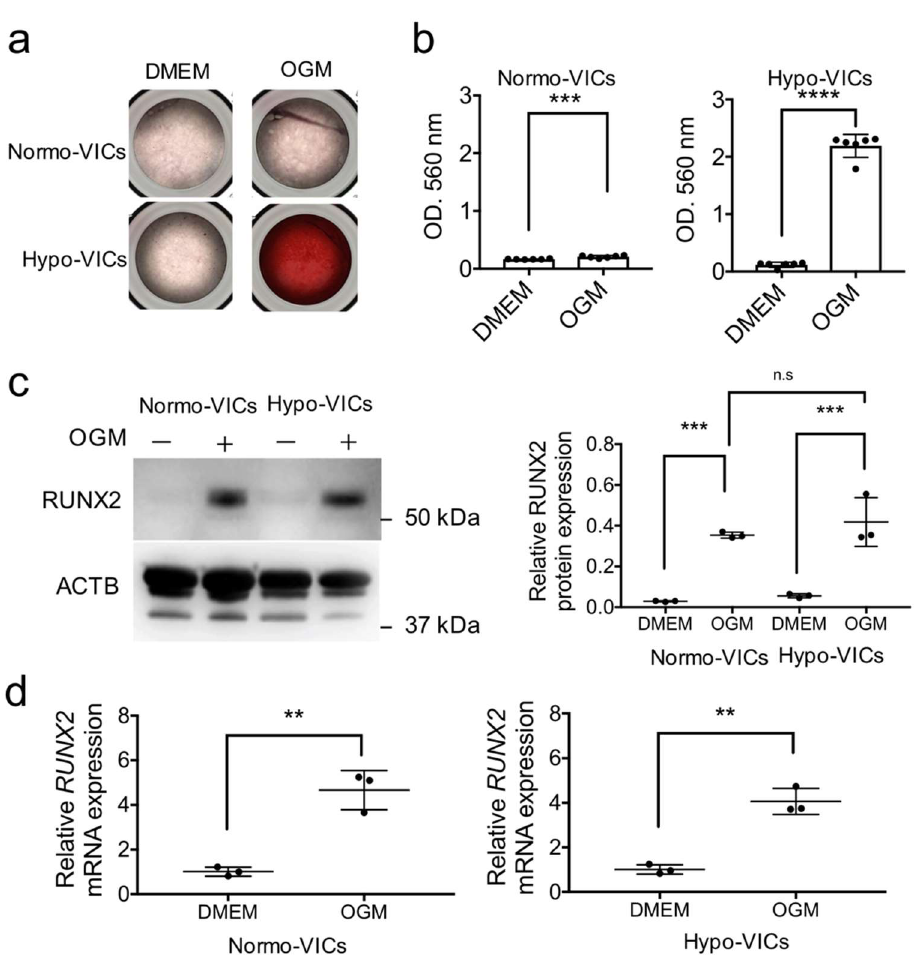
Figure 5. Differentiation of hypo- and normo-VICs into osteoblasts. ( a ) Photographs of DMEM- and osteogenic medium (OGM)-treated normo- and hypo-VICs stained by Alizarin red. ( b ) Calcium content quantified using cetylpyridinium chloride; absorbance was measured at 560 nm. Data are represented as means ± SE. ( c ) Western blot detection of RUNX2 in DMEM- and OGM-treated normo- and hypo-VICs (left panels). Beta-actin expression was used for normalization. RUNX2 protein expression in DMEM- and OGM-treated normo- and hypo-VICs (right panels). ( d ) Quantitative PCR data for RUNX2 mRNA expression in DMEM- and OGM-treated normo- and hypo-VICs. **p < 0.01, ***p < 0.001, ****p < 0.0001. n.s.: Not significant.